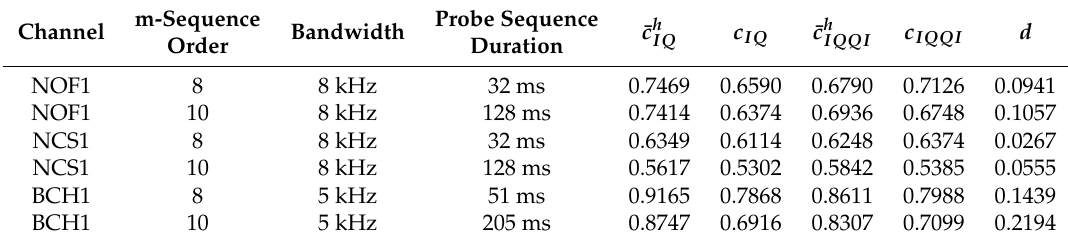
Table 1. Results of simulation